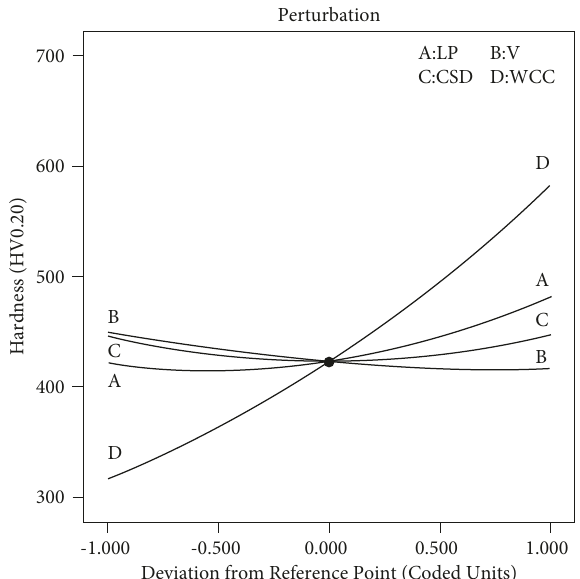
Figure 12: Perturbation diagram of the process parameters on the hardness of the cladding